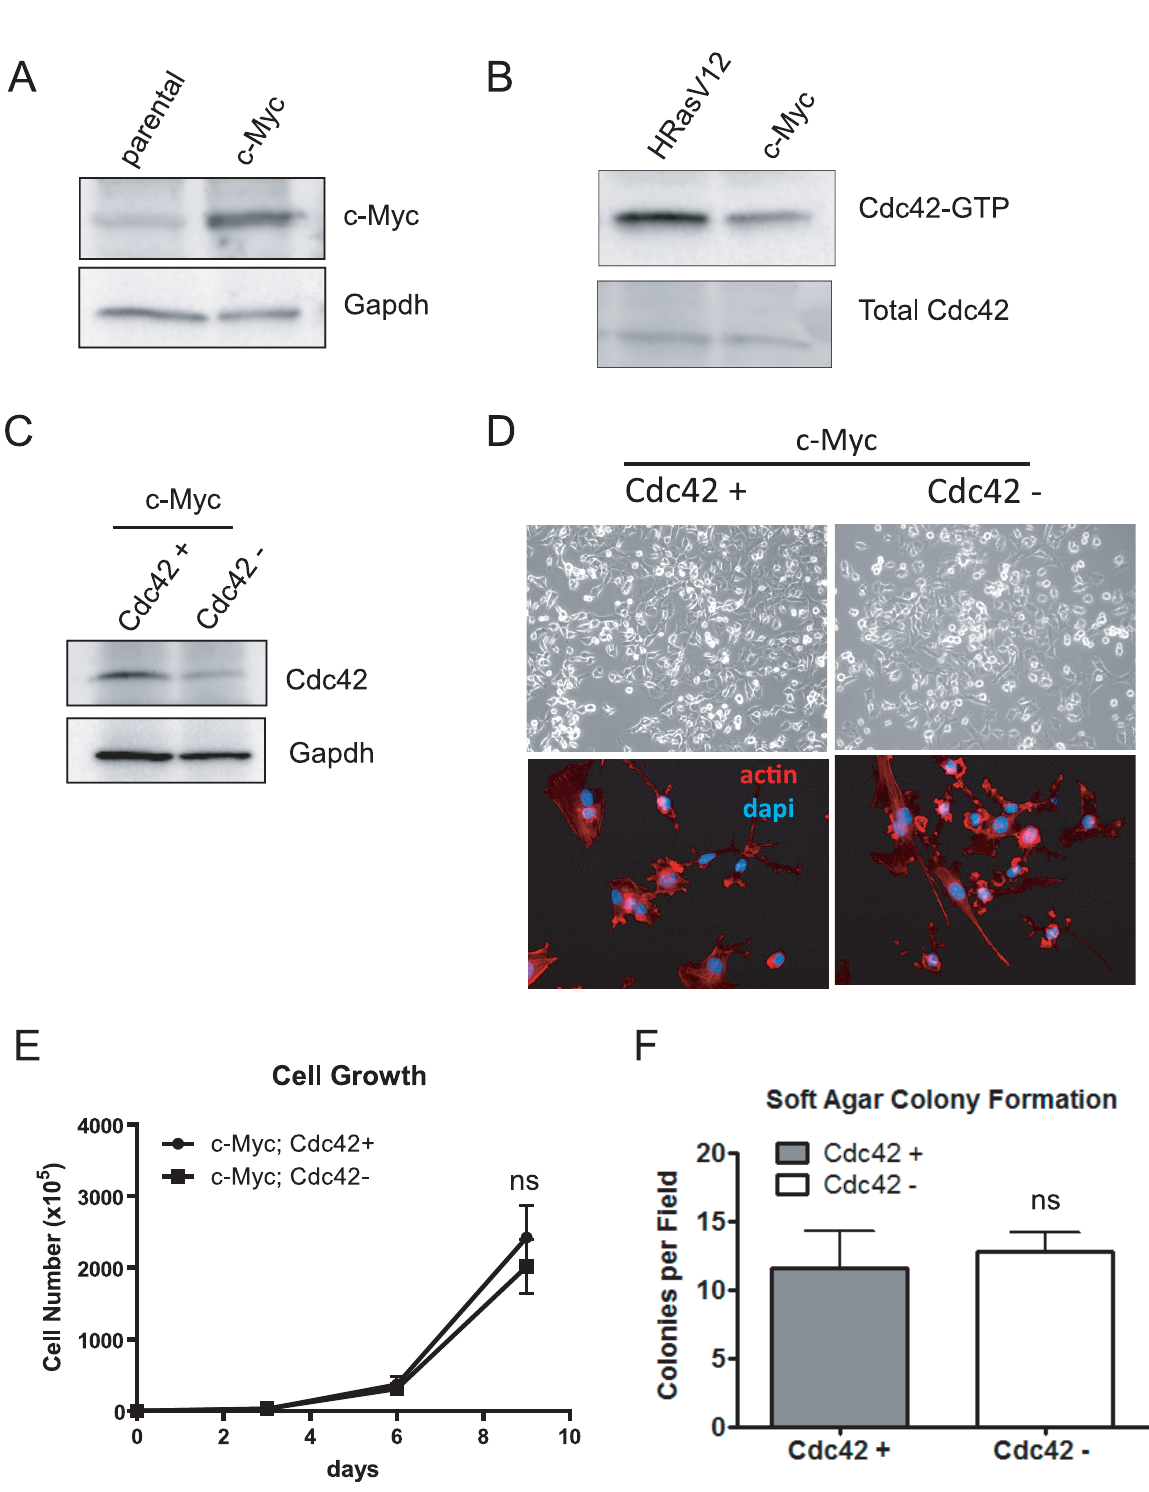
Figure 5. Cdc42 loss does not impair transformation by the oncoprotein, c-Myc. ( a ) p53-immortalized cells were infected with a retrovirus expressing the oncoprotein, c-Myc. c-Myc overexpression was verified by western blot analysis. ( b ) Pull-down assays were performed with GST-PAK1 to determine the relative abundance of activated Cdc42 in HRasV12 vs. c-Myc transformed cells. ( c ) Lysates from c-Myc transformed cells infected with Ad-GFP or Ad-GFP-Cre were immunoblotted for Cdc42. ( d ) Cultured c-Myc transformed cells were visualized 4 days following cdc42 deletion by bright field microscopy (upper 2 panels). Cells were fixed and stained with rhodamine-phalloidin and DAPI to visualize actin structures (lower 2 panels). ( e ) An equal number of c-Myc transformed Cdc42 proficient and deficient cells were seeded. Cells were counted every three days by trypan blue exclusion. Curves represent at least two independent experiments performed in triplicate. ( f ) Cdc42-proficient and –deficient c-Myc cells were grown in a 0.3% agarose solution. Experiments were performed in triplicate and 9 independent fields were counted for colonies. ns=not significant.